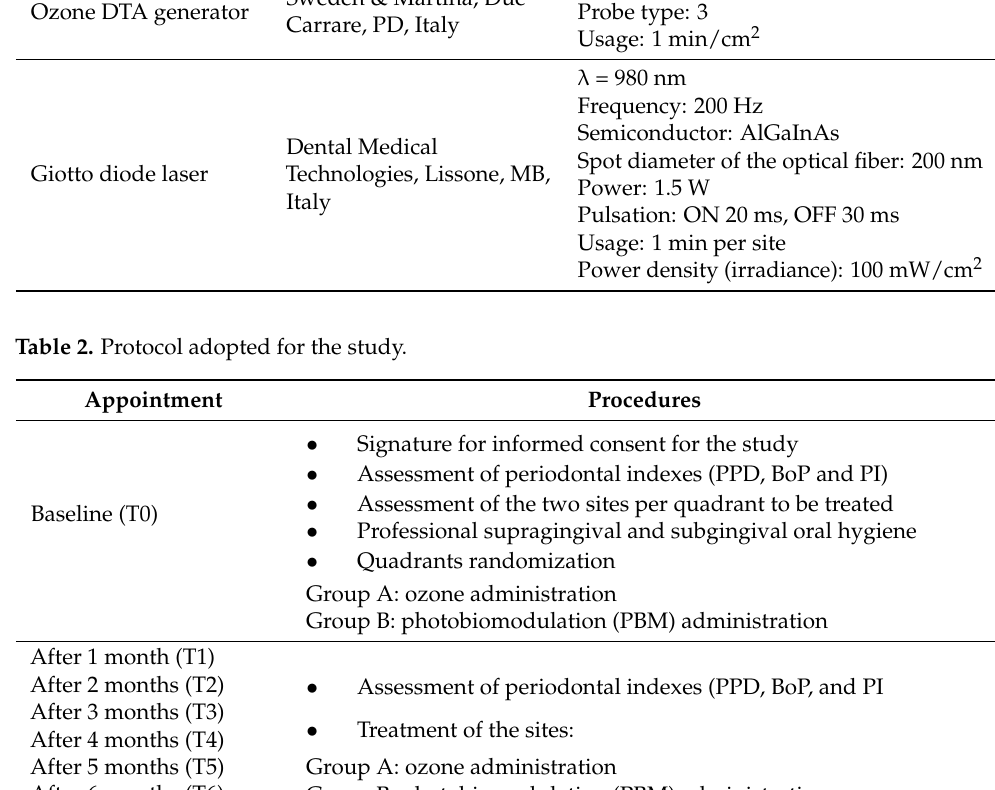
Table 2. Protocol adopted for the study.